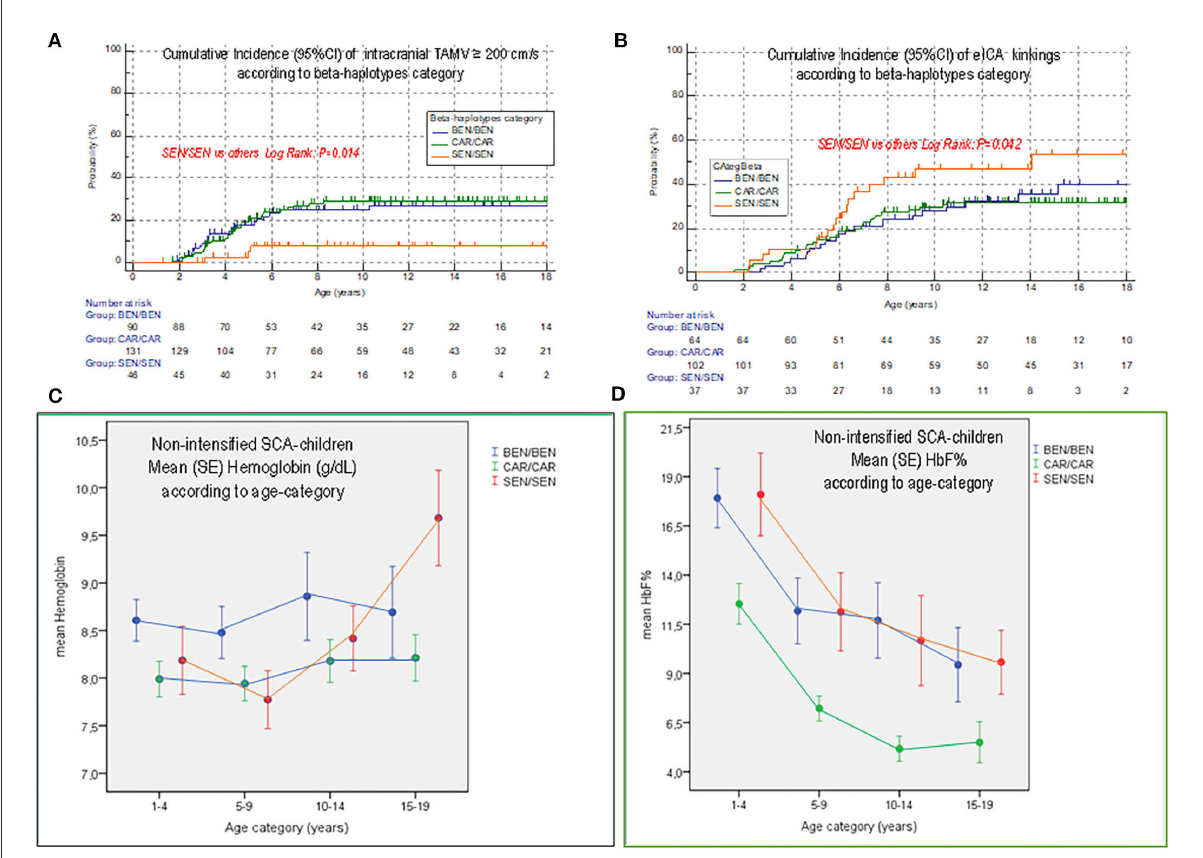
FIGURE5 Comparison of cumulative incidence of intra- and extracranial TAMV and kinkings according to homozygous beta-haplotype category and outcome of hemoglobin level and HbF% in non-intensified children according to the three beta-haplotypes categories. (A) Cumulative incidence of intracranial TAMV ≥ 200 cm/s according to homozygous beta-haplotypes category. (B) Cumulative incidence of eICA kinkings according to homozygous beta-haplotypes category. (C) Outcome of hemoglobin level during aging in non-intensified patients (not on hydroxyurea, or on chronic transfusion, or transplanted) according to homozygous beta-haplotypes category. (D) Outcome of HbF% level during aging in non-intensified patients according to homozygous beta-haplotypes category. These values were recorded at annual checkup in non-intensified children with SCA. While mean hemoglobin remained relatively stable during aging in children with BEN/BEN and CAR/CAR, hemoglobin decreased in children with SEN/SEN between 5 and 10 years of age before significantly increasing thereafter. Thus, children with SEN/SEN were the most anemic between 5 and 10 years of age and the less anemic after 15 years of age. This age period corresponds with the occurrence of abnormal TAMV and eICA kinkings in patients with